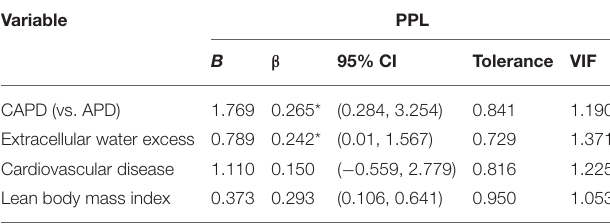
TABLE 2 | Risk factors associated with peritoneal protein loss. Variable